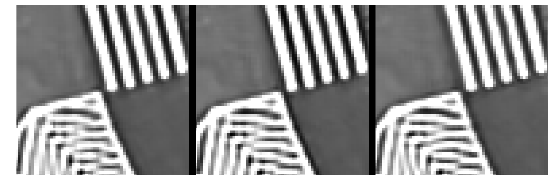
Figure 8 Architecture ablation results. Left: Shallower network. Centre: Narrower network Right: Main Network. Note the lines being better restored on the baseline model with less ringing effect and noise.